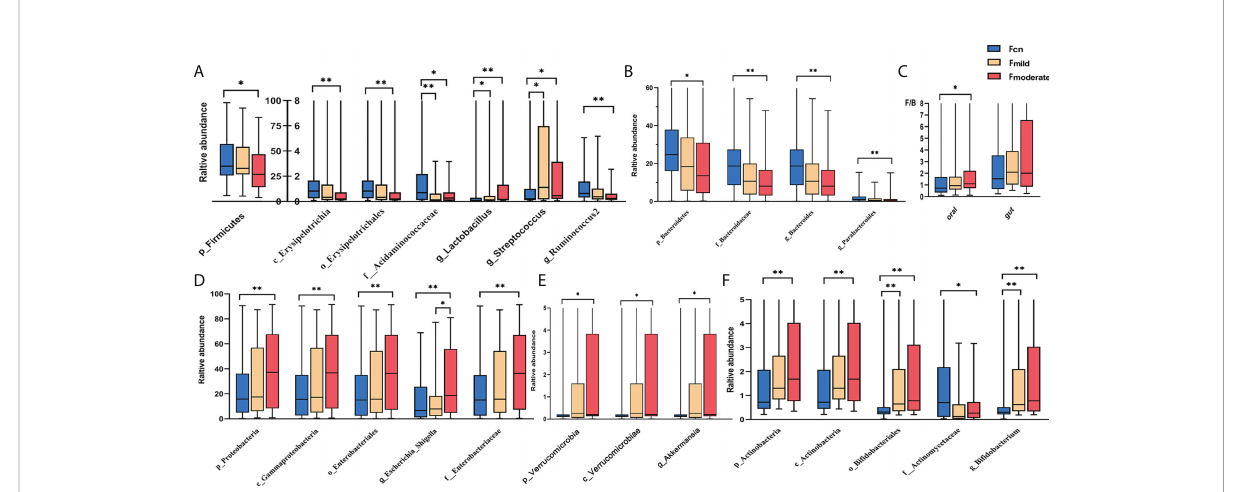
FIGURE 4 Alteration of gut predominant microbiotas among the three groups (A – F) . Comparison among the three groups by Kruskal – Wallis-test analysis, and signi fi cant taxa classi fi cations obtained by Post Hoc test using Bonferroni adjustment. * p < 0.05, ** p <0.01; Fcn, feces of normal cognition controls; Fmild, feces of mild AD; Fmoderate, feces of moderate AD; IQR, interquartile